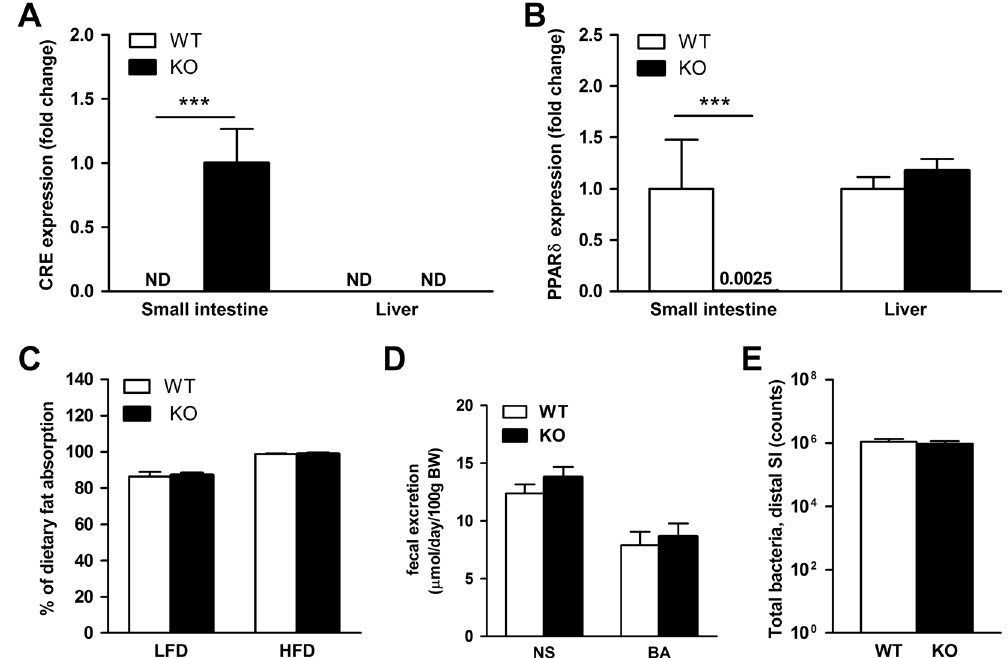
Figure 1. Characterization of mice with an intestinal epithelial specific deletion of the PPAR δ gene ( PPAR δ IEC-KO ). mRNA levels of ( A ) Cre recombinase and ( B ) PPAR δ in mucosal scrapings from the small intestine (normalized to 36b4); ND = not detectable; ( C ) Fat balance (% of dietary fat absorption) in mice on a LFD and HFD (45% energy content in fat); ( D ) Fecal excretion of neutral sterols (NS) and bile acids (BA); ( E ) Total bacterial counts in the distal part of the intestine (in intestinal content and mucosa combined) in wild- type and PPAR δ IEC-KO mice (n =